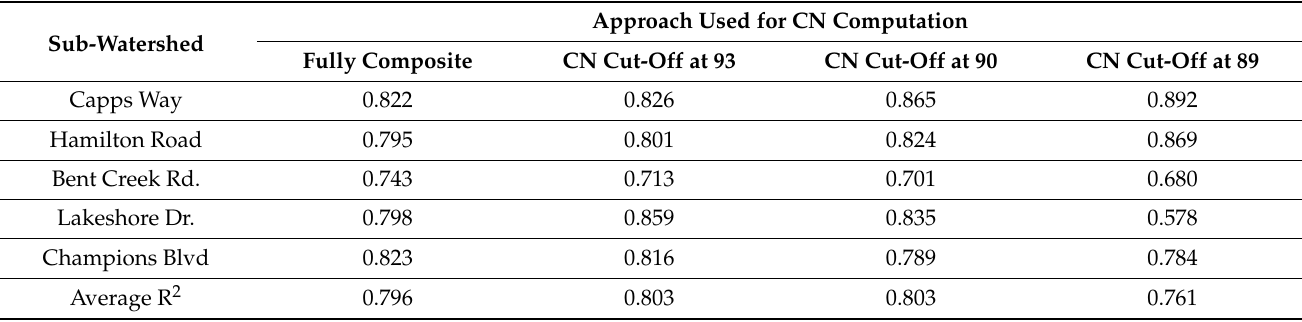
Figure 10. Bent Creek Rd. peak flow depth comparison between observed and modeled results. Table 6. R 2 results summary for peak flow depth comparison for all studied